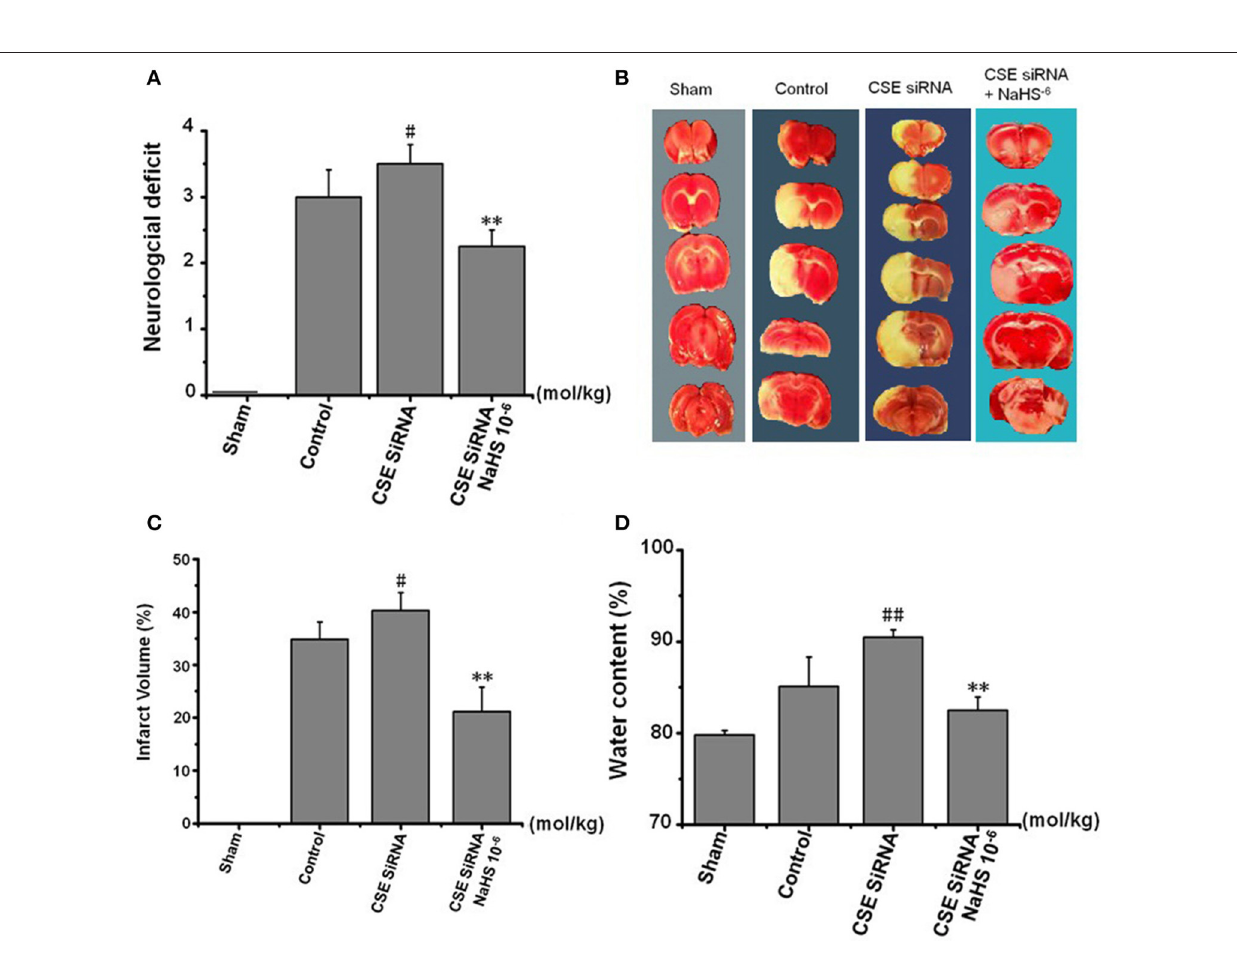
Frontiers in Neurology | www.frontiersin.org